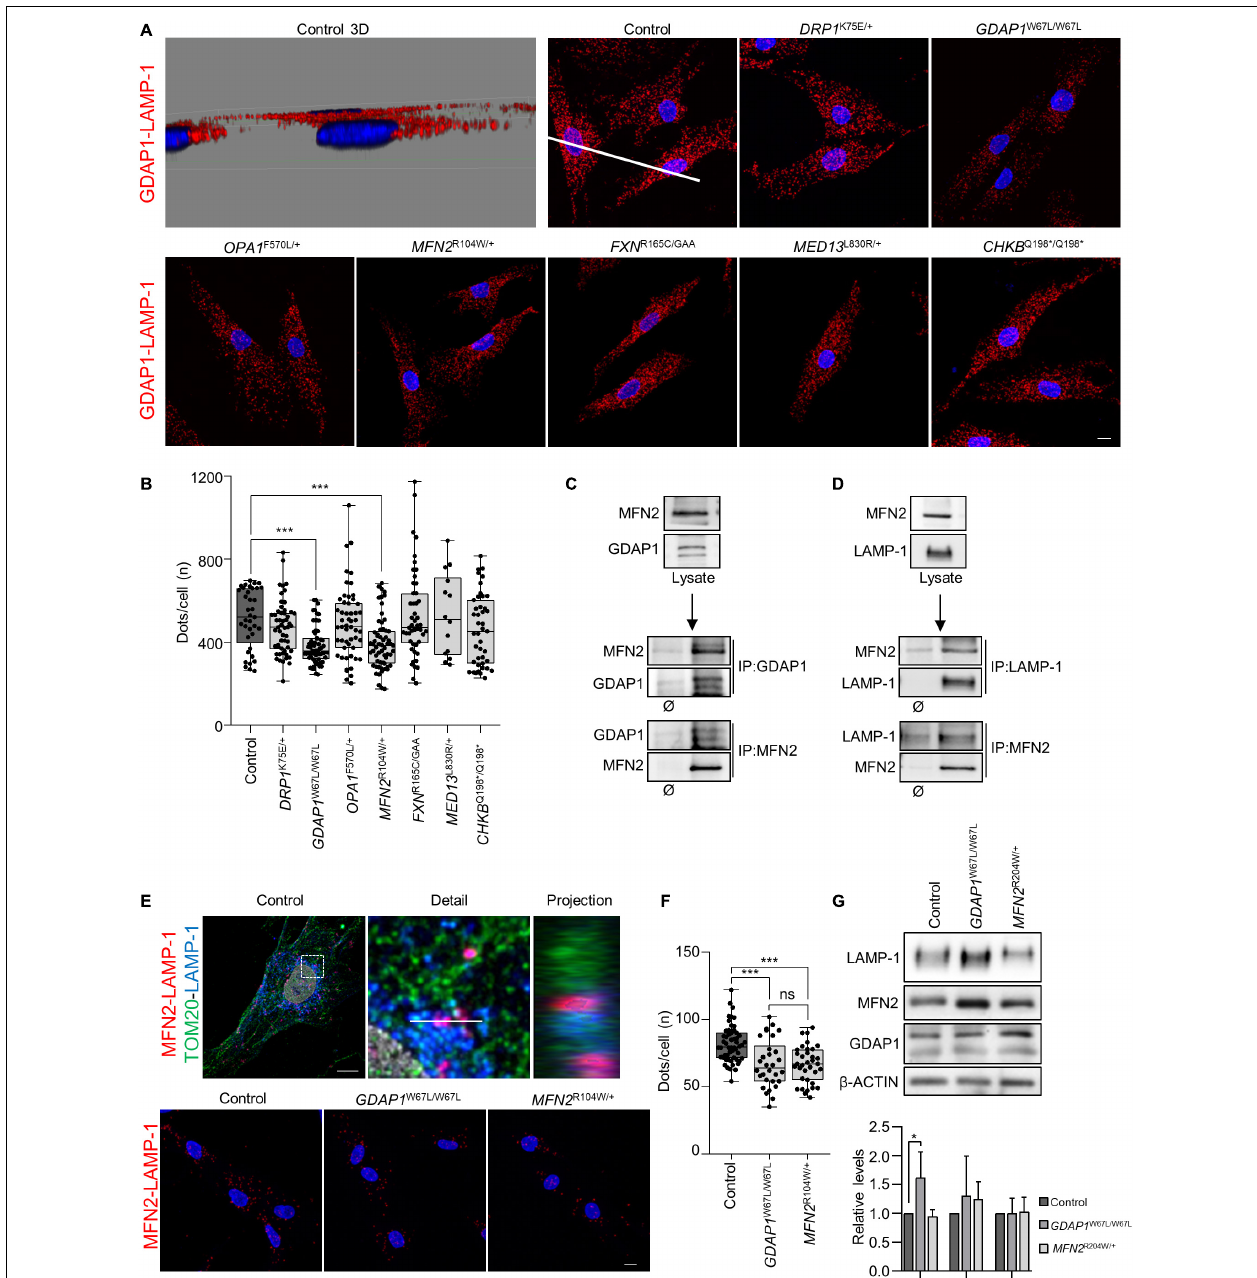
FIGURE 4 | Interaction of GDAP1–MFN2 and MFN2–LAMP-1 in patients’ fibroblasts. (A) Representative images of proximity ligation assays (PLA) of endogenous GDAP1 and LAMP-1 interaction in control and patients’ fibroblasts. Scale bar: 10 µ m. A 3D projection of the control image is shown to verify the dots localization outside the nucleus. (B) Quantification of the number of GDAP1-LAMP-1 dots per cell. The box plot lines correspond from the bottom of the box to the top: 25th percentile, median percentile, 75th percentile. The whiskers extend to the minimum and maximum values. Four independent experiments. Kruskal–Wallis followed by Dunn’s multiple comparisons test. *** P < 0.001. (C) Co-IP assay of endogenous GDAP1 and MFN2 in control fibroblasts. (D) Co-IP assay of endogenous MFN2 and LAMP-1 in control fibroblasts. (E) Proximity ligation assay with mitochondrial (TOM20, green) and lysosomes (LAMP-1, blue) co-staining in control cells, showing the dots between these organelles ( upper panel ). A deconvoluted image with an orthogonal projection is shown. Scale bar: 10 µ m. Representative images of PLA of endogenous MFN2 and LAMP-1 interaction in control, MFN2 R104W / + and GDAP1 W67L / W67L fibroblasts (panel below). Scale bar: 10 µ m. (F) Quantification of the number of MFN2-LAMP-1 dots per cell. The box plot lines correspond from the bottom of the box to the top: 25th percentile, median percentile, 75th percentile. The whiskers extend to the minimum and maximum values. Three independent experiments. Kruskal–Wallis followed by Dunn’s multiple comparisons test. *** P < 0.001; ns, not significant. (G) LAMP-1, MFN2 and GDAP1 relative protein levels in control, GDAP1 W67L / W67L and MFN2 R104W / + fibroblasts. Quantification is shown in the panel below. Data represent mean ± SD. One sample t -test with multiple comparison adjustment. Three independent experiments. * P <